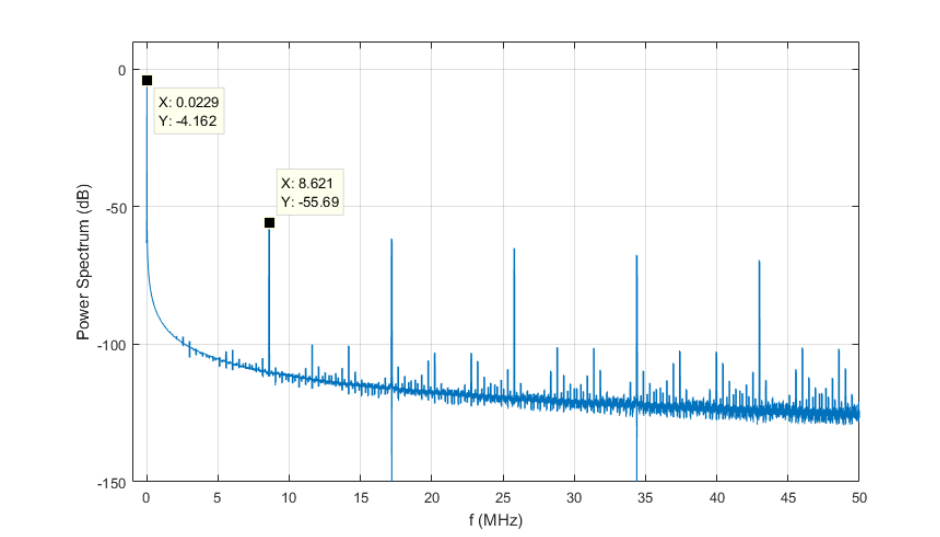
Figure 11. Sidelobe level as a function of fractional quantum q = 1